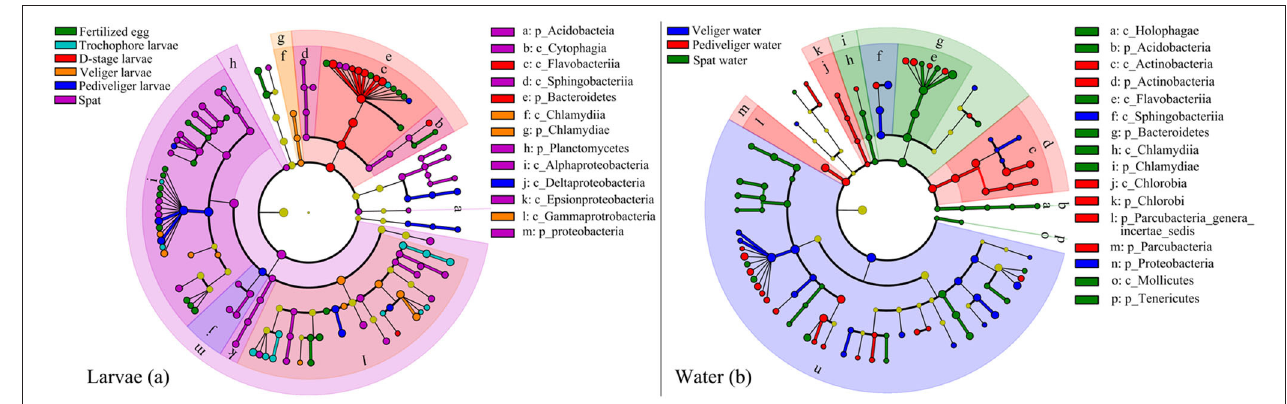
FIGURE 3 | Linear discriminant analysis taxonomic cladogram shows discriminatory taxa with significant differences in their relative abundances at the OTU level in larval oyster (a) and rearing water (b) at each developmental stage. The bacterial groups affiliated from phylum to genus level are listed from center to outside. The diameter of each circle is proportional to the abundance of the bacterial taxon. Significant discriminatory nodes are colored, and branch areas are shaded according to the highest-ranked group for that taxon. If the taxon is not significantly different between the groups, the corresponding node is colored yellow. p_, phyla; c_,